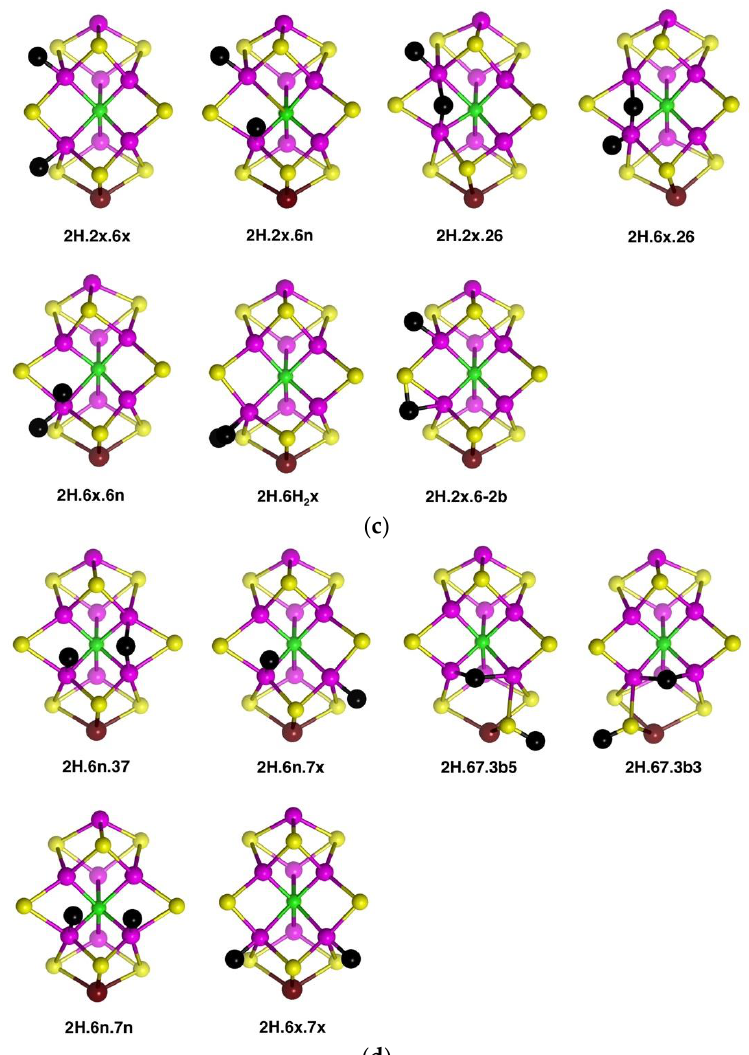
Figure 5. Optimised structures with two H atoms (black) bonded to FeMo-co. These pictures are simplified by hiding the ligands at Fe1 and Mo. Fe–S distances <2.5 Å are drawn as bonds, Fe–S distances in the range of 2.5 to 3 Å are marked with a black/white striped connector, and Fe–S non-bonds are >3 Å . ( a ) Structures with the four S3BH conformation added to S2BH, exo -Fe2H, or exo -Fe6H. ( b ) Structures with S2BH and H on Fe2 or Fe6. ( c ) Structures without an H on S2B, and one Fe-H 2 structure. ( d ) Structures with H bound to Fe7.